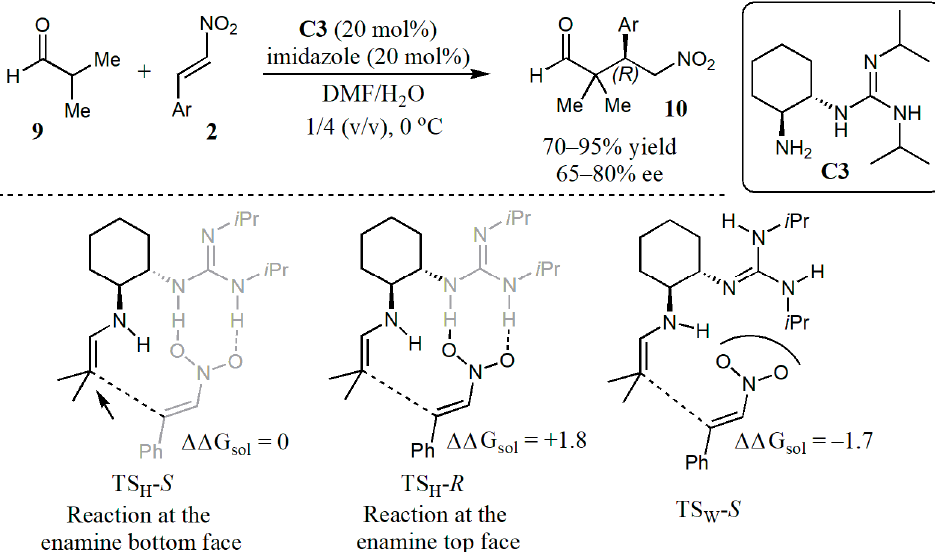
Figure 8. Enantioselective Michael addition of isobutyraldehyde to nitroalkenes catalyzed by C3 (top) and comparison of the guanidine activated transition states (TS H -S and TS H -R) with the water-activated TS (TS W -S). Free Gibbs energies computed at B3LYP/6-311+G(d,p) (CPCM, water) level [32].